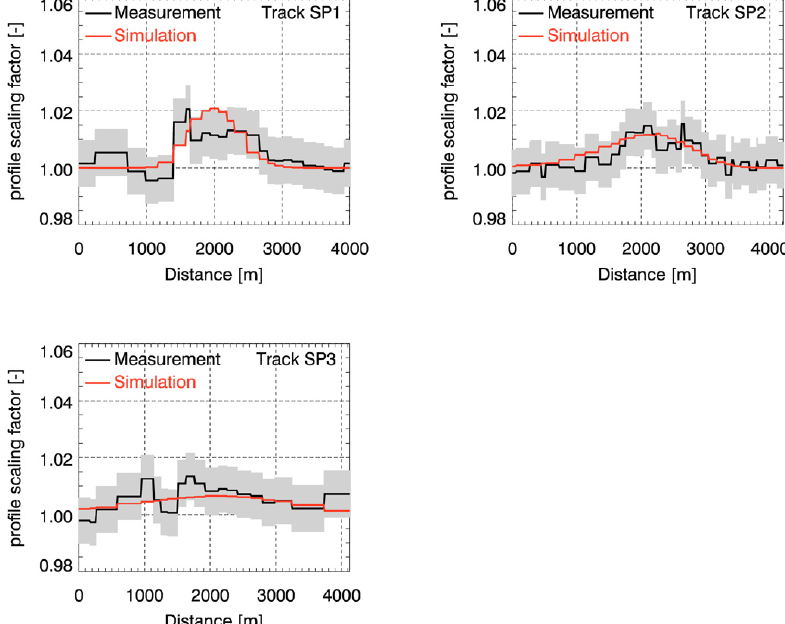
Fig. 9. The figure shows model data (red) computed from the Gaussian plume inversion and measurements (black) in case of Schwarze Pumpe power plant along horizontal cross sections through the CO 2 plume. Statistical errors are shown in grey. For the track numbers compare Fig.